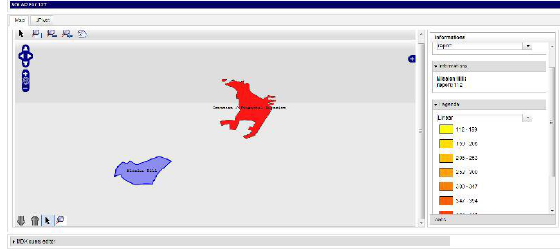
Figure 7. Map tab of the developed system